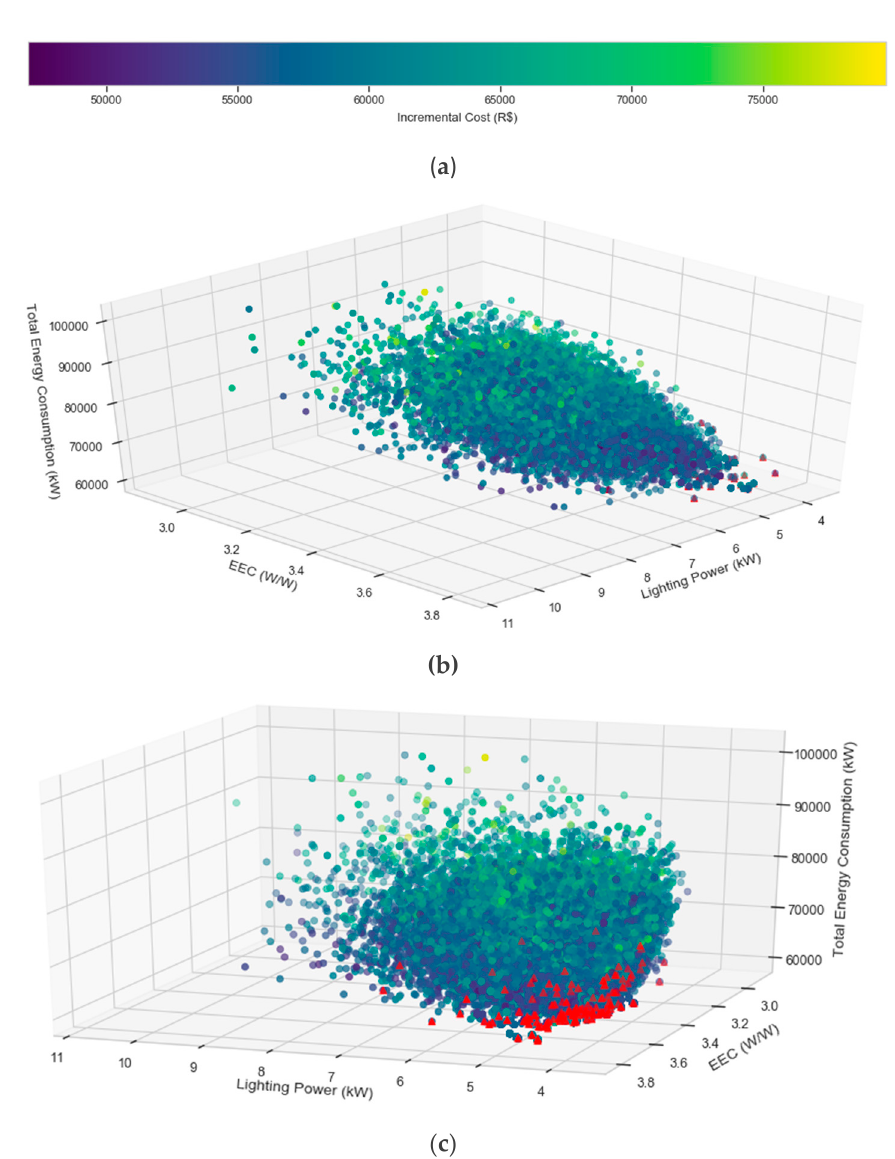
Figure 7. Pareto Curve in the form of a 3D scatterplot ( a ) The color scale of the Incremental Cost Objective, ( b ) Pareto Curve of Case 2—With Lures and ( c ) Pareto Curve of Case 2—With Lures turned at approximately 270°.